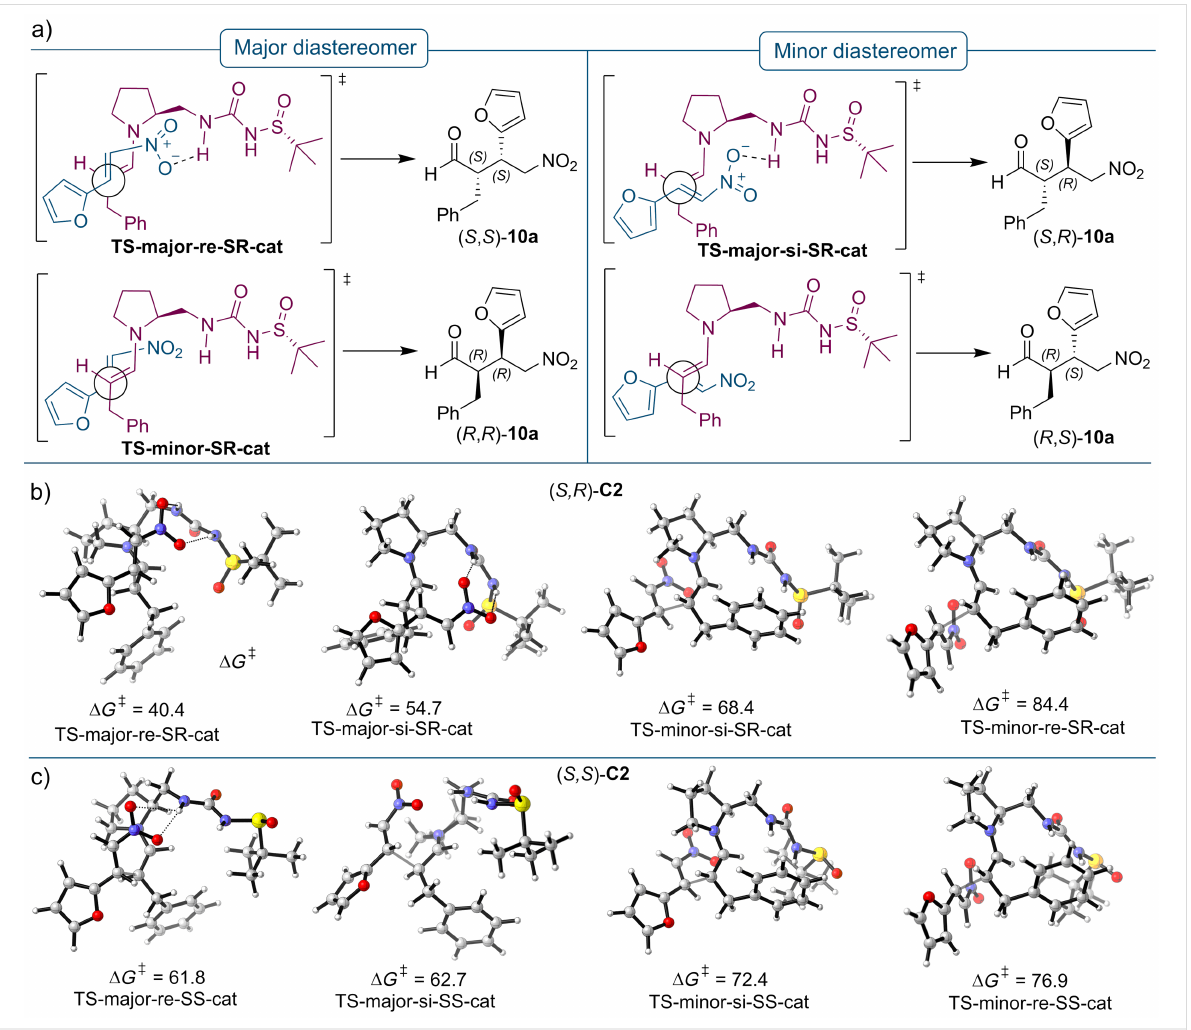
Figure 3: a) Arrangements of reactants in the transition states; b) DFT-calculated (PBEh-3c/def2-SV(P)//M06-2X/def2-TZVP) transition states with catalyst ( S , R )- C2 ; c) calculated transition states with catalyst ( S , S )- C2 ; Gibbs free energies of activation in kJ/mol.